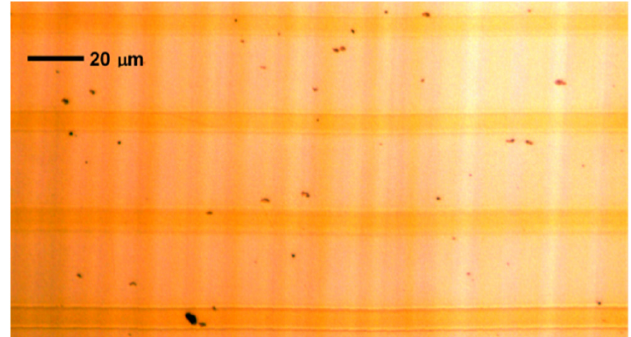
Figure 6. Interference phase contrast microphoto of parts of four channel waveguides written in an Er: tungsten-tellurite glass with a microbeam of 11 MeV C 4+ ions. Irradiated fluence of the lowermost channel was 4.6 · 10 14 ions/cm 2 , and 1.4 · 10 14 ions/cm 2 for the others.